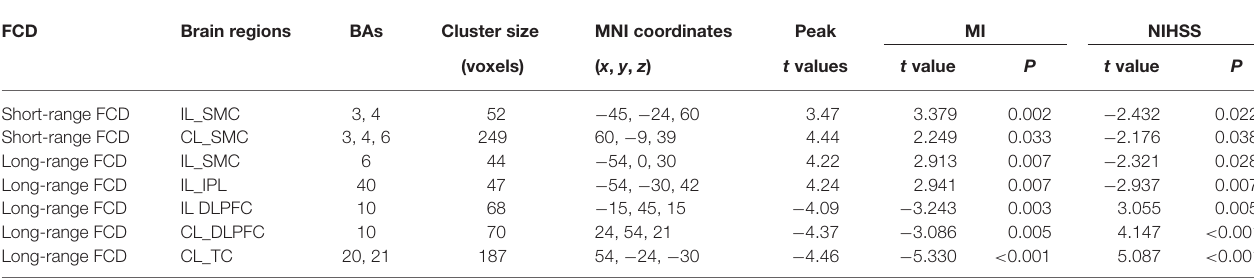
TABLE 2 | Linear FCD changes after stroke ( P < 0.05, corrected) and correlations between functional indices and clinical parameters . FCD Brain regions BAs Cluster size MNI coordinates